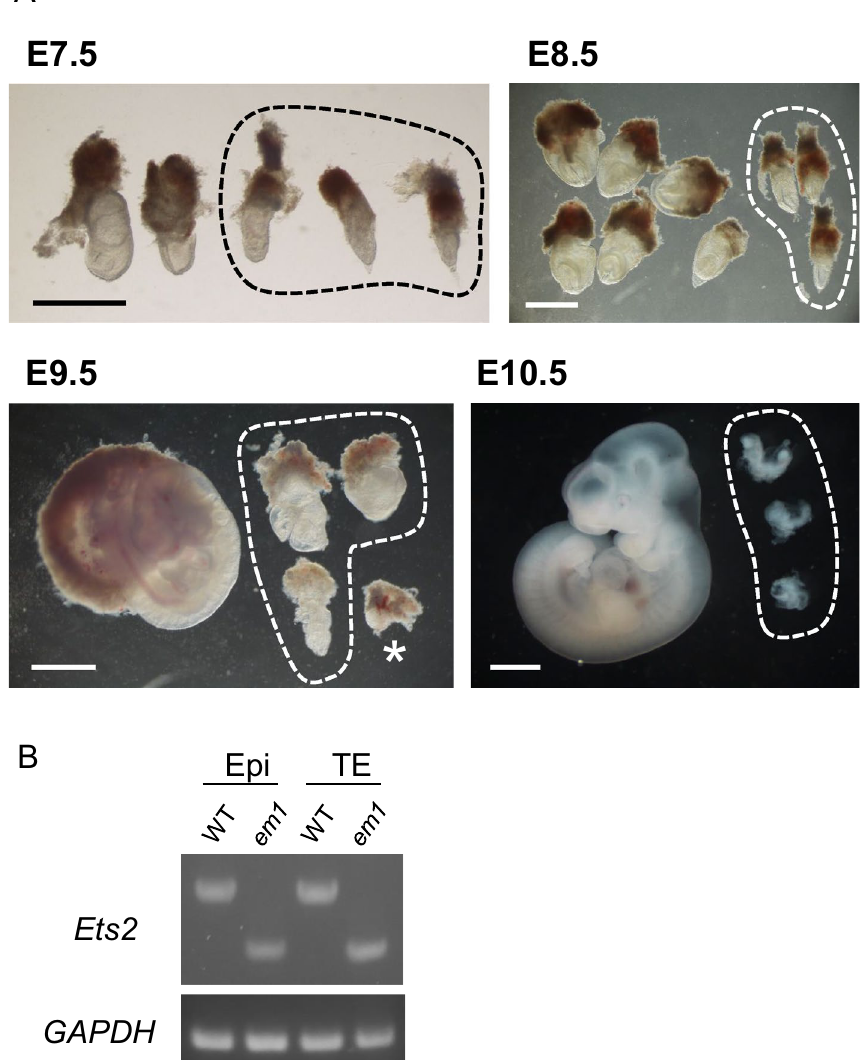
Figure 2. Development of Ets2 em1/em1 embryos. (A) From E7.5 to E10.5, embryos were observed after crossing Ets2 + /em1 females and males. Ets2 em1/em1 embryos are indicated as circles in each picture. The regions outside of the circles correspond to Ets2 + / + or Ets2 + /em1 embryos. The genotype of the embryo indicated by an asterisk at E9.5 could not be determined. All scale bars indicate 1 mm. (B) Gene expressions of E7.5 WT and Ets2 em1/em1 (em1) embryos. Embryos were separated into trophectodermal tissue (TE), including ectoplacental corn, and epiblast (Epi), from which RNA and cDNA were prepared. Both em1 bands were shifted to be lower than the WT bands. The DNA sequences of the em1 bands were the same as em1L in Fig. 4B.